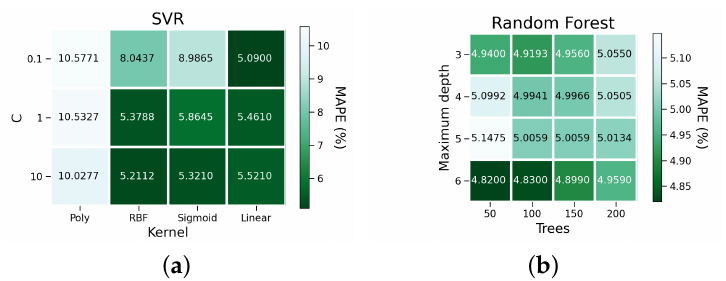
Figure 6. RMSE grid search result for ( a ) SVR and ( b ) Random Forest.